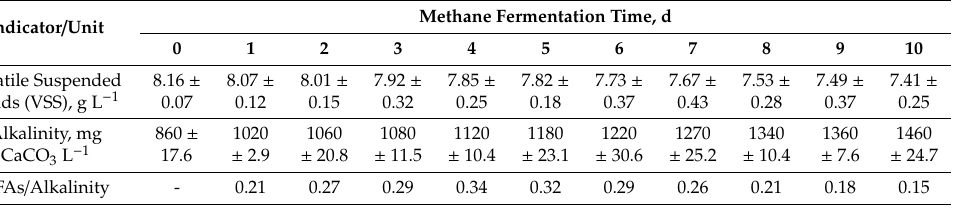
Table 2. Changes of physico-chemical parameters of excess sludge in the 10-day methane fermentation process.